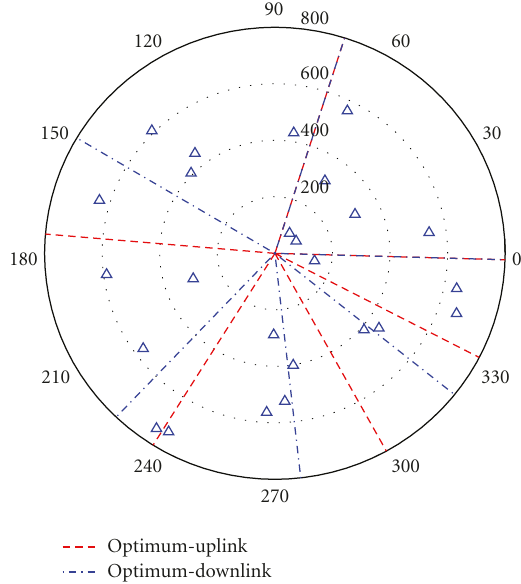
Figure 4: Comparison of optimum sectorization with random sig- nature for uplink and downlink; uniform terminal